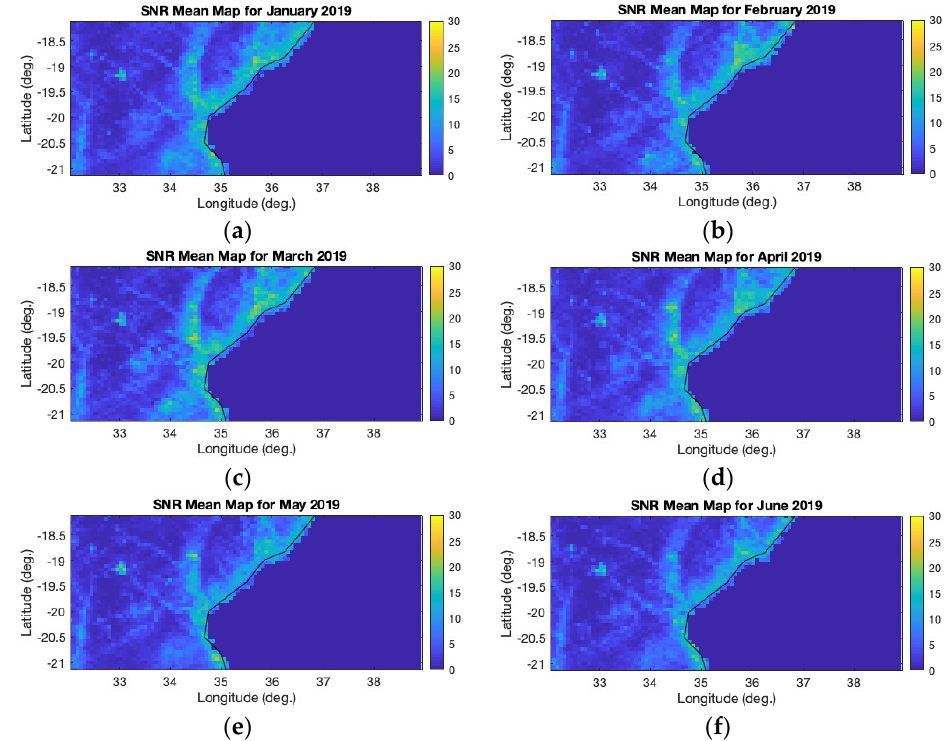
Figure 5. SNR monthly means obtained from CYGNSS data for ( a ) January, ( b ) February, ( c ) March, ( d ) April and ( e ) May, and ( f ) June 2019.